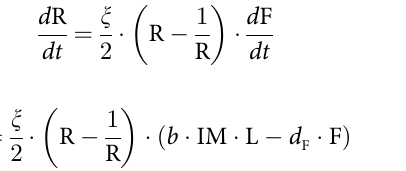
Fig 2. Experimental scenarios and respective step functions of LDL-C uptake. The upper diagram shows the step functions of LDL-C uptake d inserted small spaces between the lines to improve visibility of single lines), and the lower one represents the corresponding experimental settings for scenarios 1–13 ( ▶ : start of observation, # : start of a medication or diet, − + − : measurement time